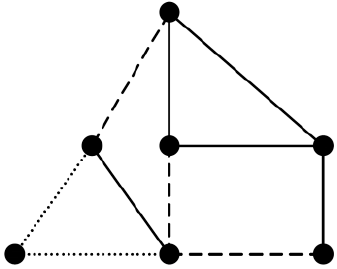
Figure 1. Power system graph representation example; the structure at the starting moment is marked by dotted line, possible edges for which weights have to be calculated are marked by dashed line, edges not included in the analysis because they create a cycle or are not adjacent to the dotted structure are marked by solid line.